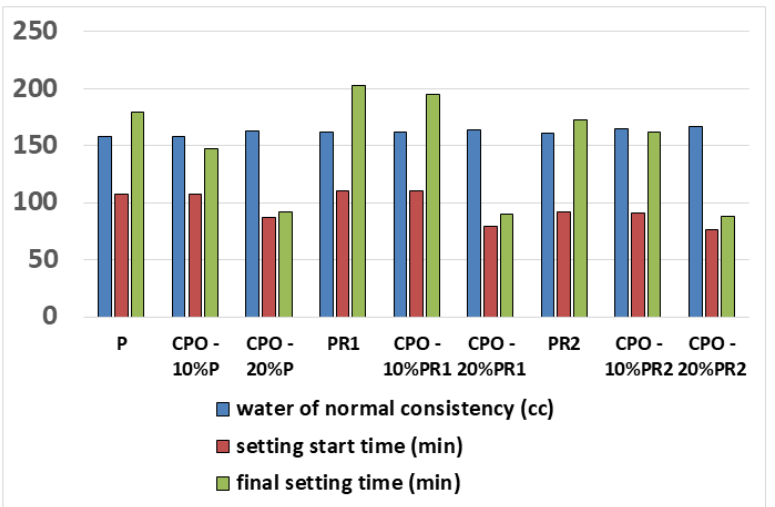
Figure 1. Setting related parameters for each mixture.